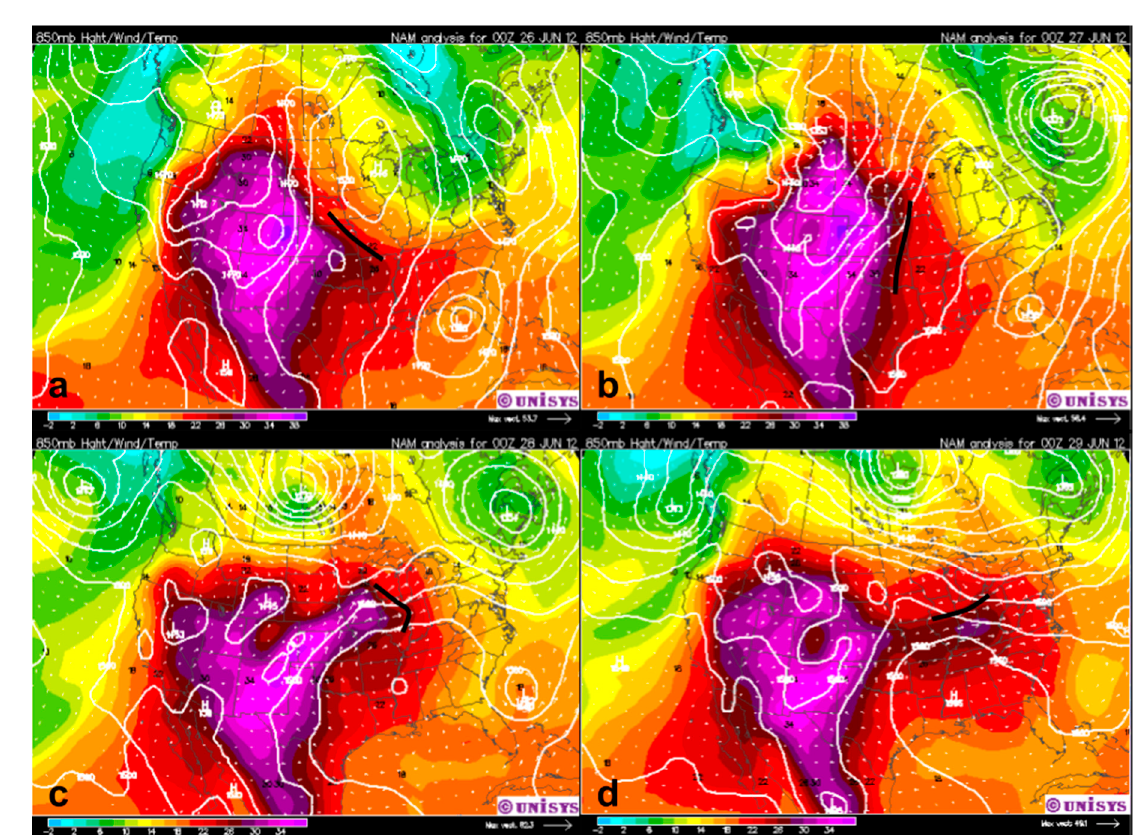
Figure 4. 850 hPa temperature ( ° C) and height (m) analyses from Unisys Weather (original source no longer available ) for ( a ) 00Z 26 June, ( b ) 00Z 27 June, ( c ) 00Z 28 June, and ( d ) 00Z 29 June 2012. The thick black line in each panel indicates the “leading edge” of the EML (i.e., the EMLF).